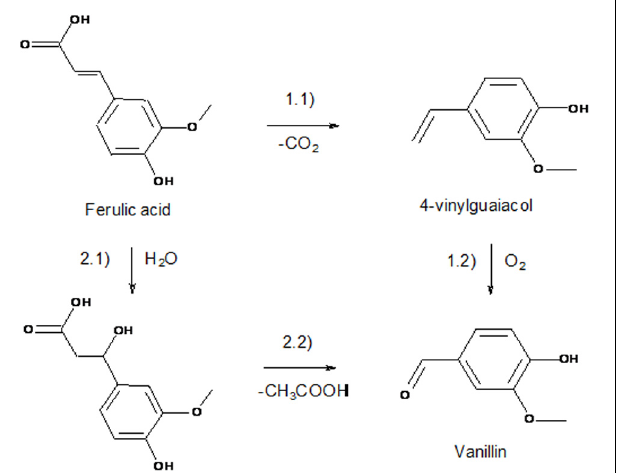
FIGURE 6 | Lignin primary by-products